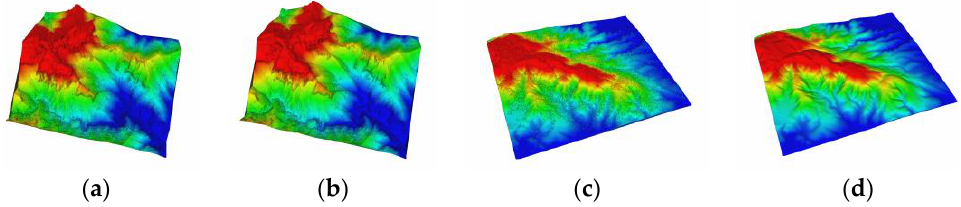
Figure 6. ( a , b ) Elevation rendering of digital surface model (DSM) and manual extraction digital elevation model (DEM), respectively, of dataset I; ( c , d ) elevation of DSM and manual extraction DEM, respectively, of dataset II.